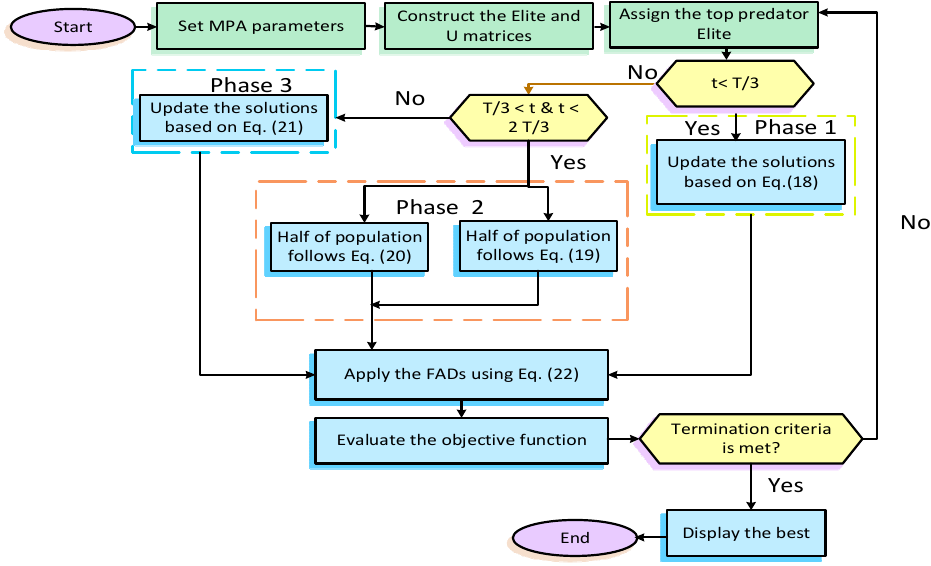
Figure 1. Flow diagram of the marine predators algorithm (MPA).